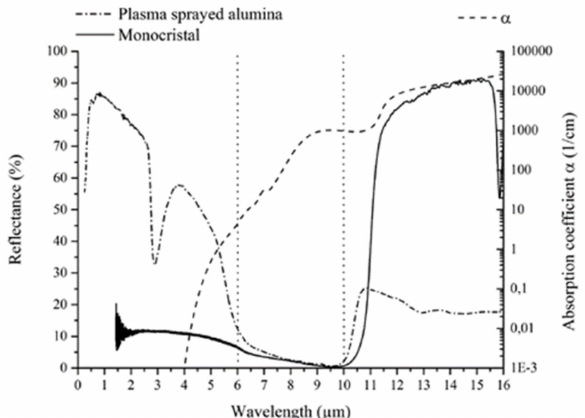
Figure 3. The reflectance of plasma sprayed alumina coating and reflectance of a single crystal of α -alumina (left axis). The absorption coefficient of α -alumina is computed from extinction index, reproduced from [27], with permission of ACS 2015.